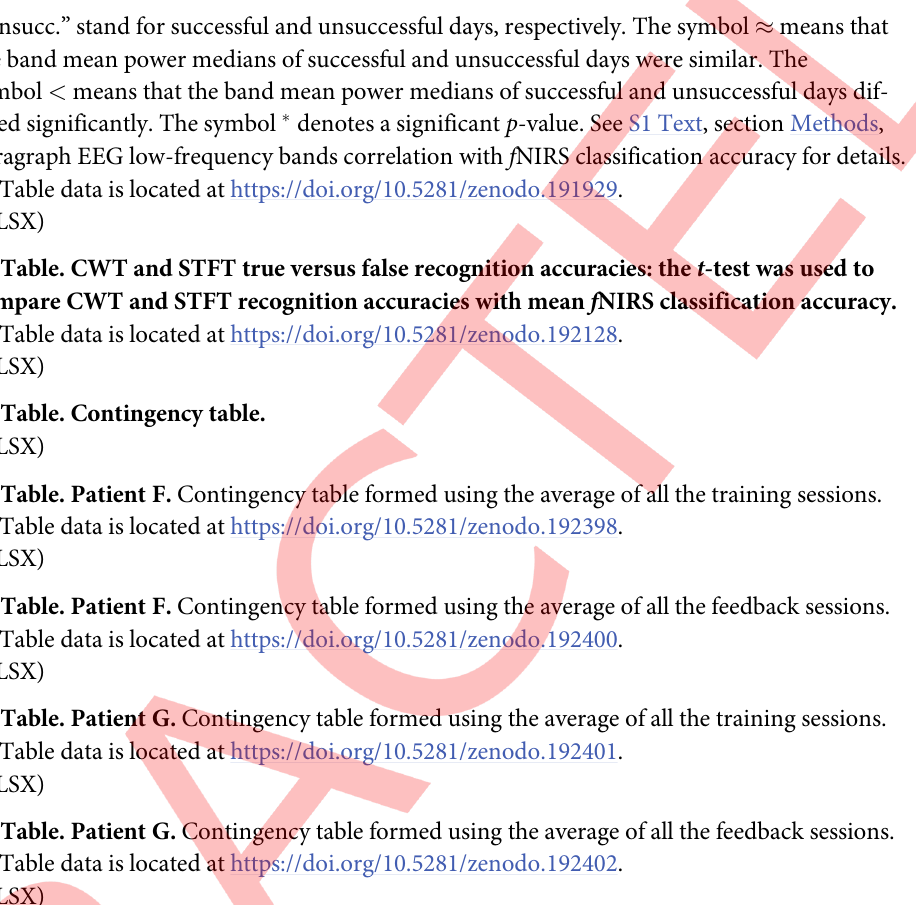
S2 Table. CWT and STFT true versus false recognition accuracies: the t -test was used to compare CWT and STFT recognition accuracies with mean f NIRS classification accuracy.